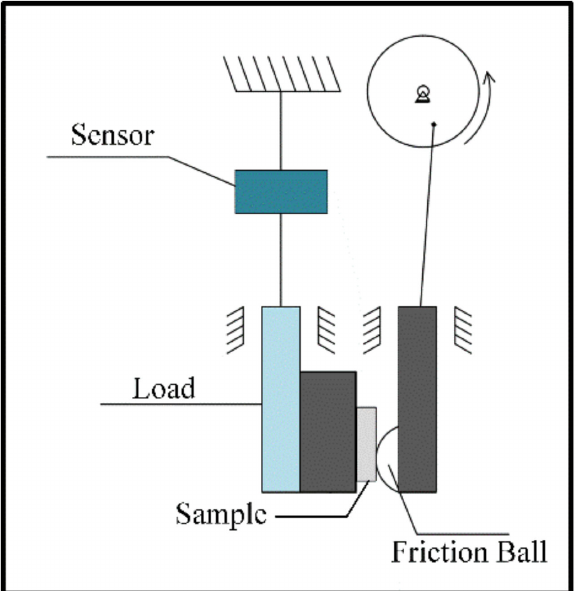
Figure 3. Equipment for the wear